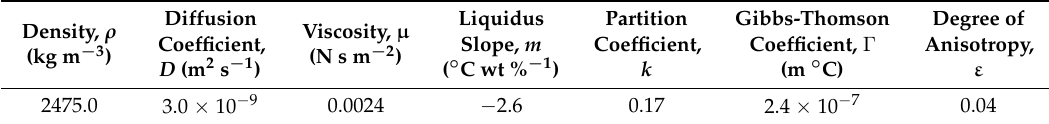
Table 1. Physical properties of Al-Cu alloy used in the simulations.